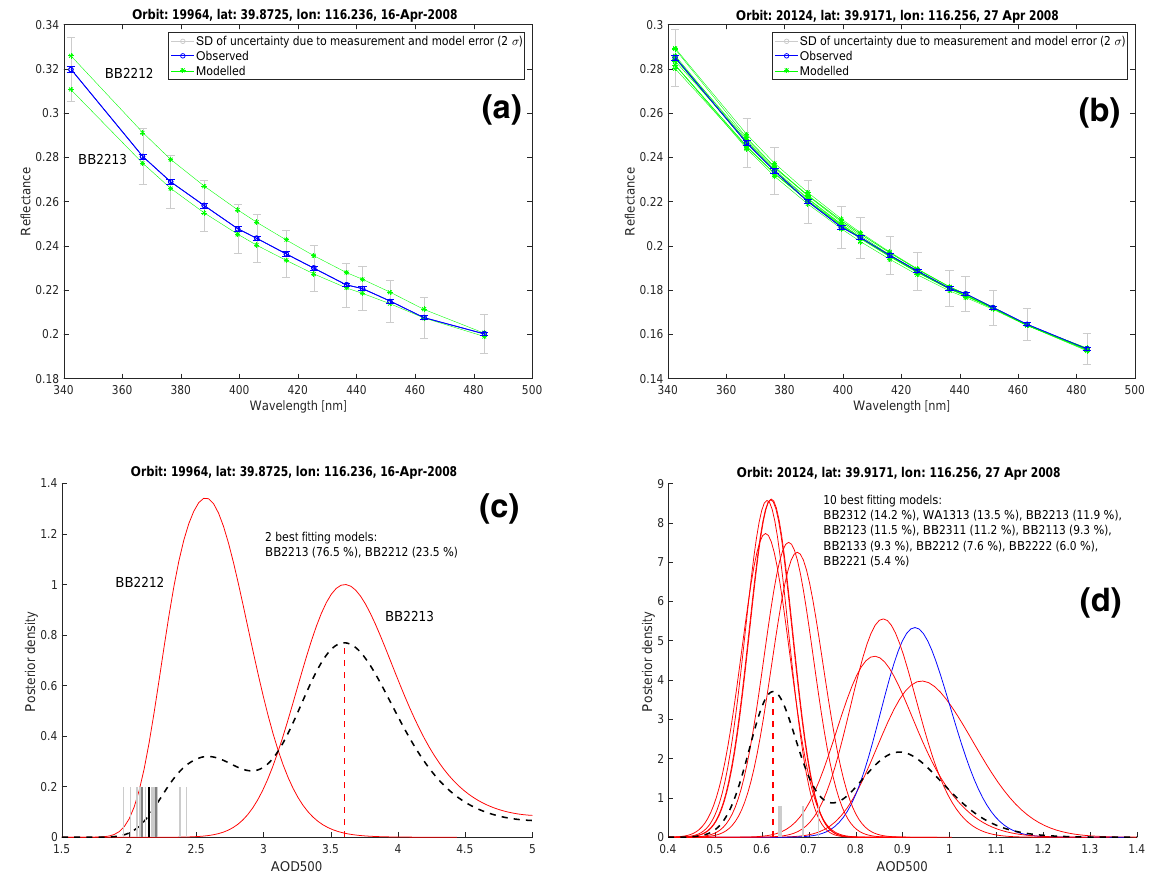
Figure 7. Beijing, 16 April (a, c) and 27 April (b, d) . (a, b) The observed reflectance (blue dots) and modelled reflectance (green dots) of the selected best-fitting models. The error bars in blue correspond to 2 × standard measurement error and the error bars in grey correspond to 2 × standard uncertainty due to measurement and model error. (c, d) The posterior probability distribution of AOD for each best-fitting model. The biomass-burning-type model’s posterior density curve is in red and weakly-absorbing-type model’s curve in blue. The dashed black curve is the averaged posterior distribution over the best-fitting models (Eq. 7). The red vertical dashed line indicates the MAP estimate from the averaged posterior distribution. The grey vertical lines show AERONET version 2 direct-sun level 2.0 AOD at 500nm values position at the horizontal axis. The darker grey vertical lines (c) denote AERONET AOD values ( n = 3) within a 2h time window including OMI overpass time and the black vertical line is the average of these values.